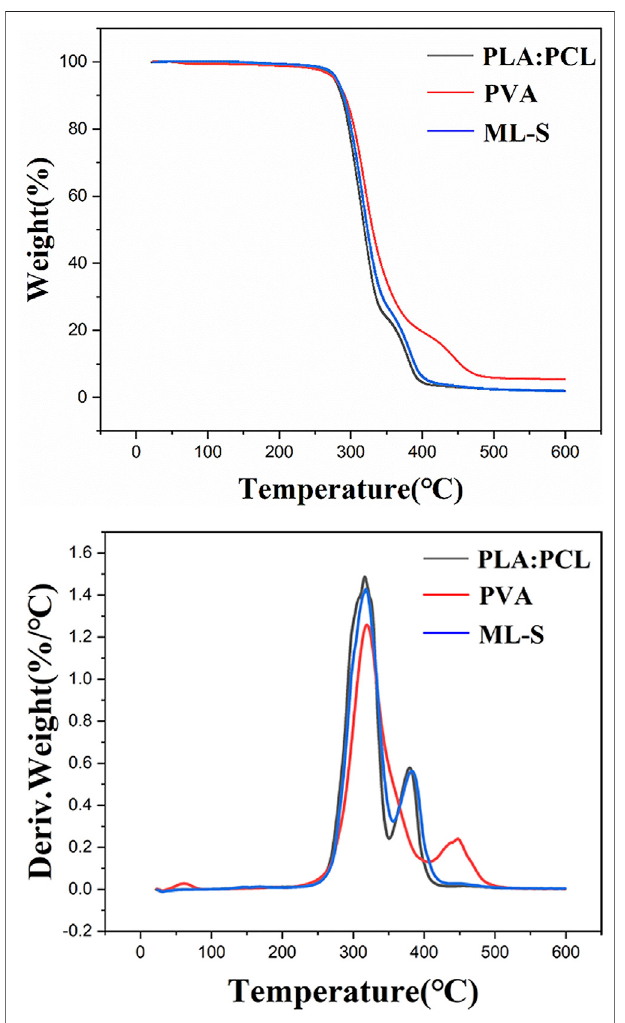
FIGURE 5 | TG and DTG pro fi les of PLA:PCL, PVA, and ML-S.